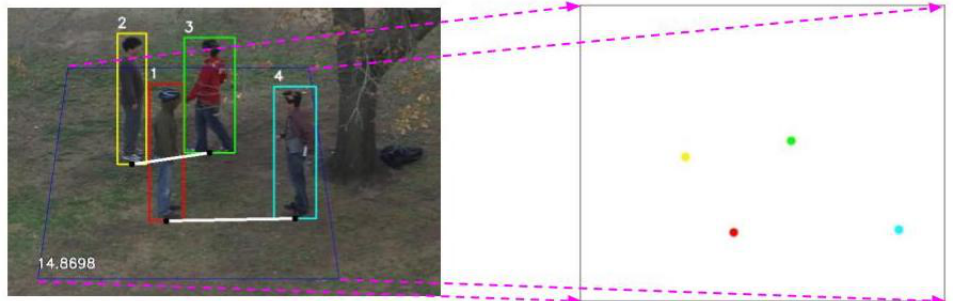
Figure 3. Perspective transformation. The ( right ) frame is a visualization of how a camera-captured scene ( left ) is projected to the ‘floor plane’ after perspective transformation. The trapezoidal floor is being transformed into a